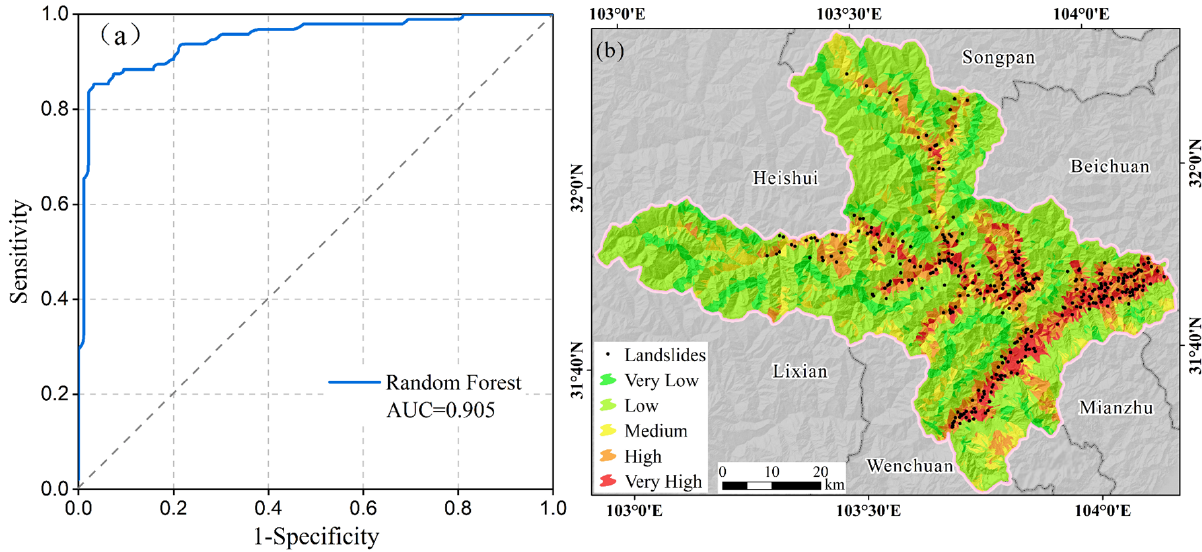
Figure 10. ( a ) ROC curve; ( b ) Landslide susceptibility map.